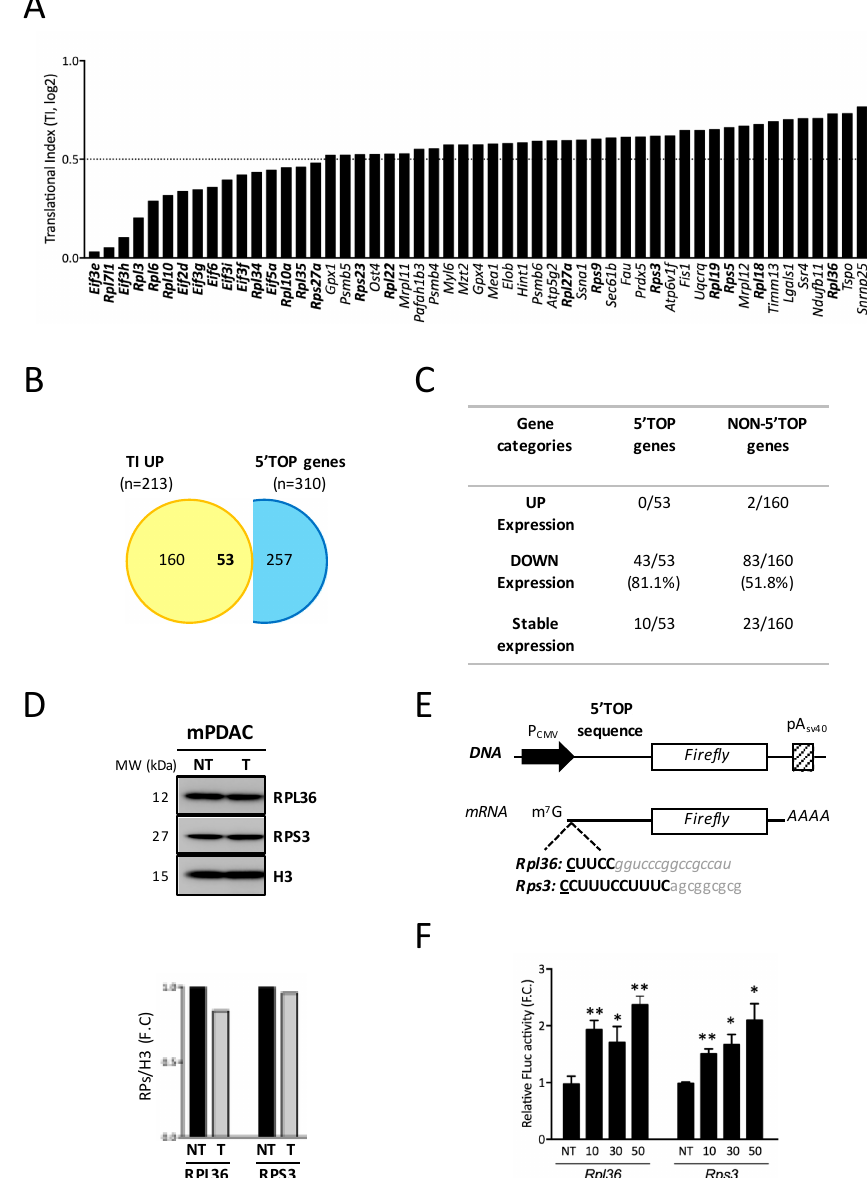
Figure 4. NCL targeting by N6L increases 5 (cid:48) TOP and 5 (cid:48) TISU mRNA translation by activating mTOR pathways. ( A )—Translation Index (T.I) for 5 (cid:48) TOP-containing mRNA under N6L treatment ( A , right). ( B )—Venn diagram comparing 5 (cid:48) TOP-gene overlap between our TI UP mRNAs and 5 (cid:48) TOP gene lists from Gentilella et al. 2017 [33]. ( C )—Summary table showing the distribution of 5 (cid:48) TOP and non-5 (cid:48) TOP mRNAs according to their transcriptional expression (up, down or stable). ( D )—mPDAC cells were treated (T) or not (NT) with N6L for 48 h, following which RPL36 and RPS3 expression at the protein level was analyzed using Western blotting ( D , upper panel) and quantified in relation to H3 ( D , lower panel). ( E )—Cartoon showing the design of 5 (cid:48) TOP firefly- luciferase reporter constructs, with the first C of the TOP motif as the +1 transcription start site (TSS). ( F )—Fold change of firefly-luciferase activities under 5 (cid:48) TOP motifs of Rpl36 and Rps3 mRNAs upon 48 h of increasing concentrations of N6L treatment in mPDAC, after normalization to mPDAC NT. * p < 0.05; ** p < 0.01 and n.s. for not statistically significant, as determined by Student t -test on the final data